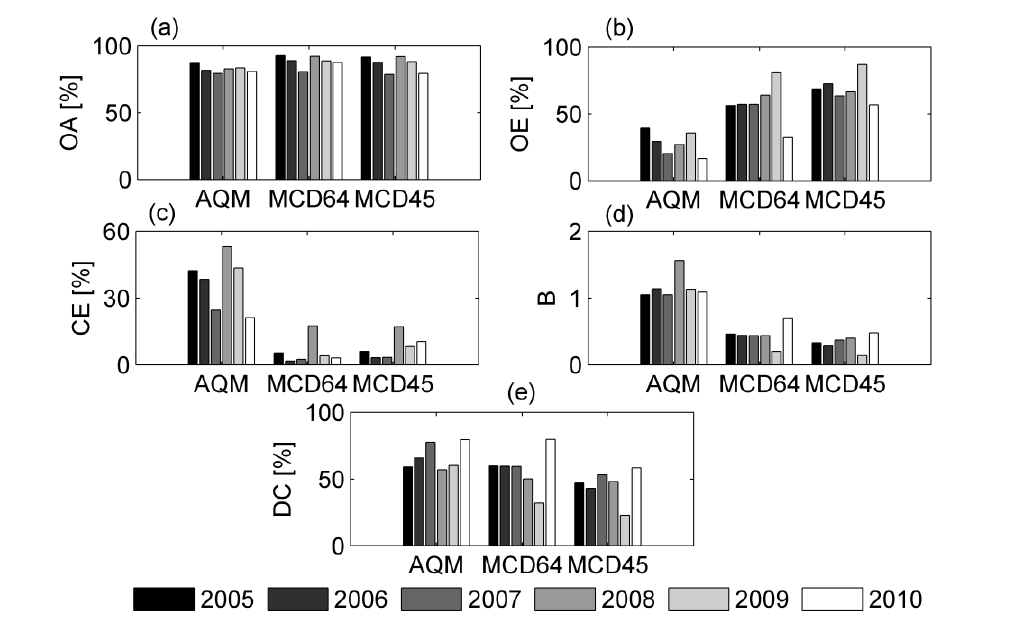
Figure 5. Verification measures from contingency tables (OA( a ); OE( b ); CE( c ); B( d ); DC( e )) for AQM and MCD64A1 and MCD45A1 versus the TM reference map over Jalapão for 2005 (JA), 2006 (JJAS), 2007 (JJA), 2008 (J), 2009 (JA), and 2010